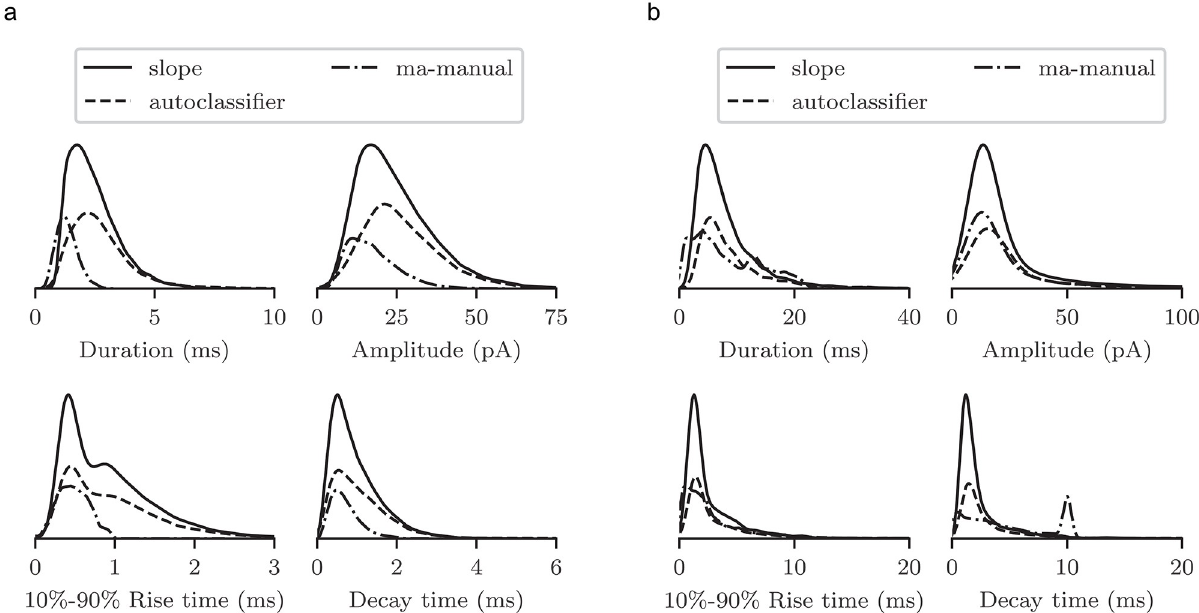
Fig 4. Kernel density distributions of the event parameters duration, amplitude, 10%-90% rise time and time constant of decay as determined by “ma-manual”, “autoclassifier”, and “slope” algorithms for horizontal cells (a) and cultured cortical neurons (b). Since the sum of the integrals of the distributions is scaled to 1, the areas represent the set size of each distribution related to the